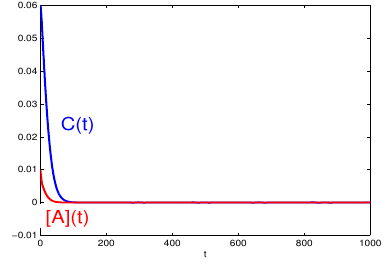
Figure 1. Simulation solution of (1.1):the equilibrium E 0 is asymptotically stable, when τ = 4 . 5 < τ 0